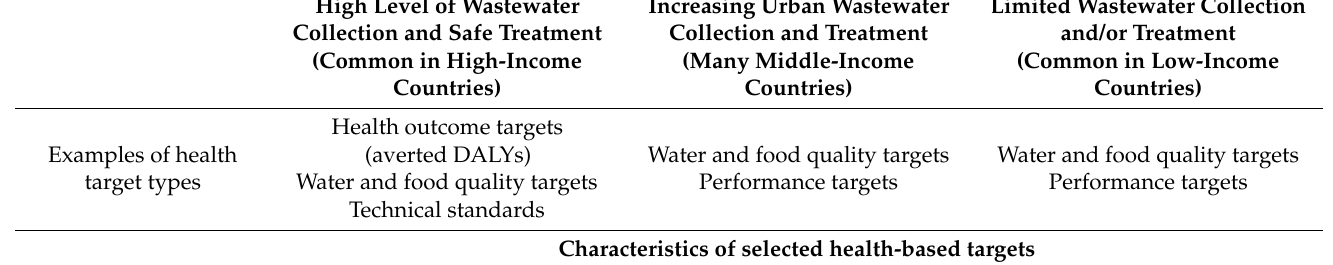
Table 3. Examples of possible health-based targets suitable for countries with different levels of wastewater collection and treatment (Drechsel and Keraita [43],